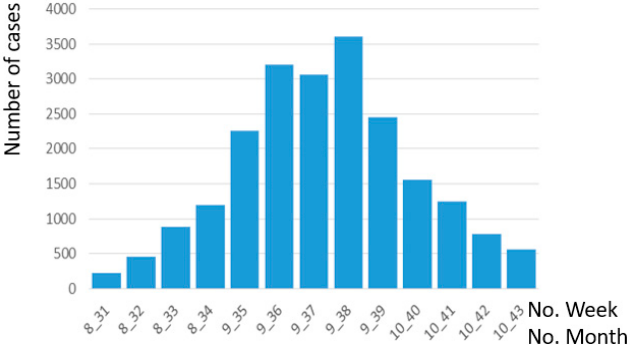
Figure 1. Number of cases in dengue outbreak from week 31 to week 43. Int. J. Environ. Res. Public Health 2016 , 13 , 1235